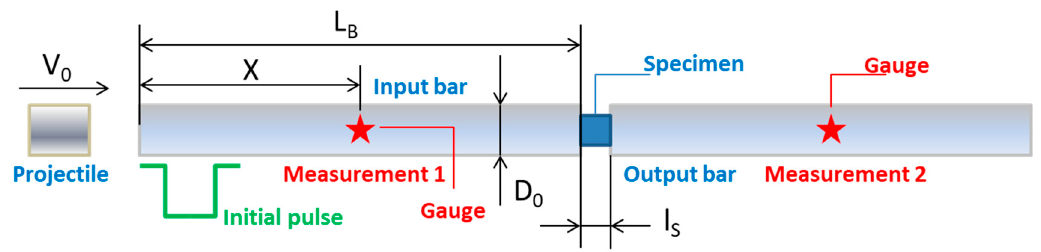
Figure 3. Compression machine set-up.